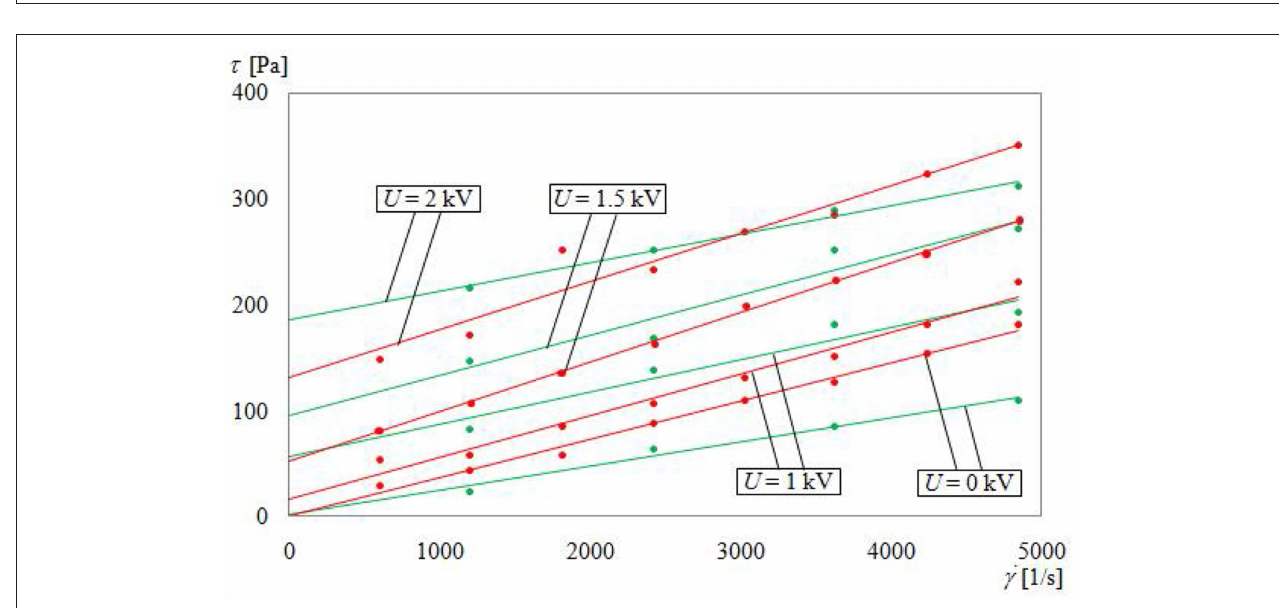
FIGURE 8 | Scheme of the test rig: 1, PLC; 2, input/output cards; 3, computer set with software; 4, high voltage power supply; 5, servo drive controller; 6, servo drive; 7, tested clutch with ER fluid; 8, force sensor; 9, humidity sensor; 10, temperature sensor.